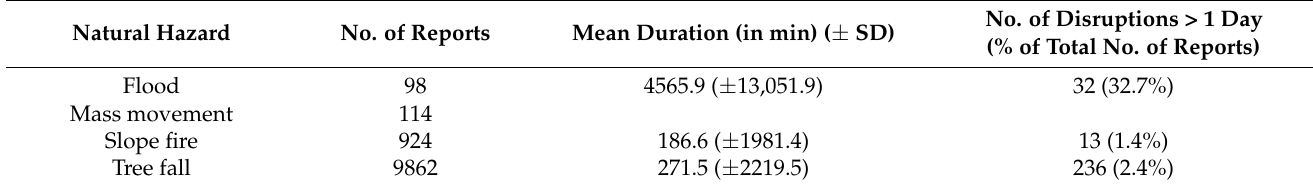
Table 2. Number of reports of the different natural hazards and the duration of the